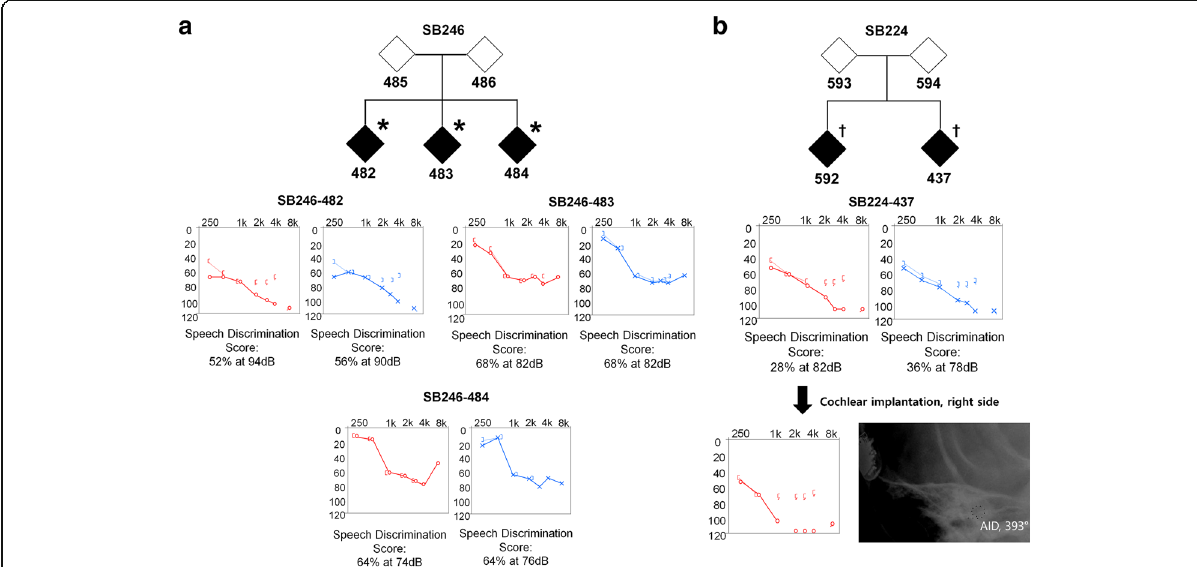
Fig. 1 Pedigree and pure-tone audiograms of family SB246 ( a ) and 224 ( b ). SB246 – 482 and SB224 – 437 showed bilateral, severe, and symmetrical SNHL. SB246 – 483 and 484 showed bilateral, moderate, and symmetrical SNHL. In all subjects, hearing at low frequencies was significantly preserved. SB224 – 437 had cochlear implantation at the age of 20. During the operation, insertion of Med-El device, Flex 24 (Angular insertion depth [28] of 393°) into the cochlea was performed, and residual hearing of low frequencies was substantially preserved. *, subjects who underwent targeted exome sequencing of 129 known deafness genes and whole exome sequencing; † , subjects who underwent targeted exome sequencing of 129 known